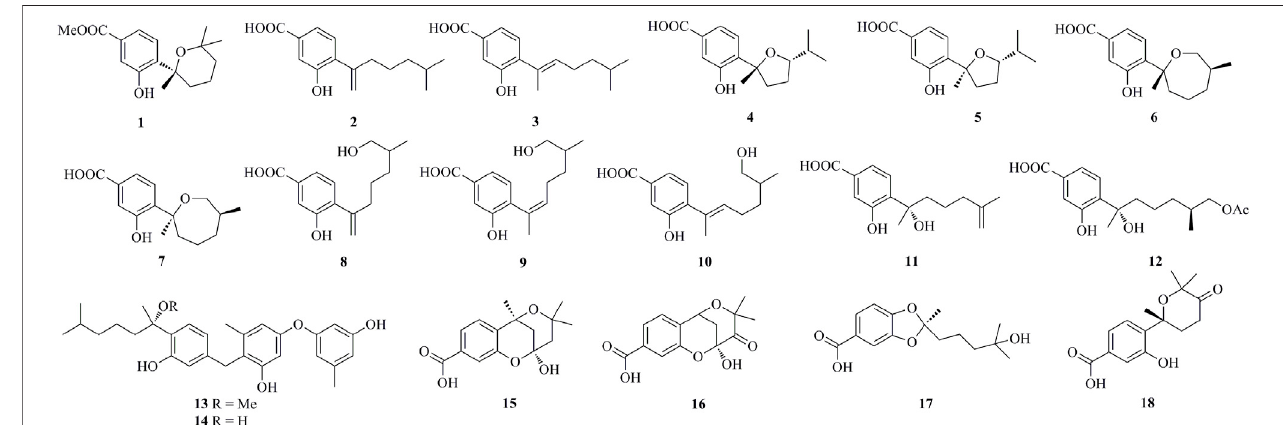
FIGURE 1 | Bisabolanes characterized from marine-derived fungi ( 1 – 18 ).